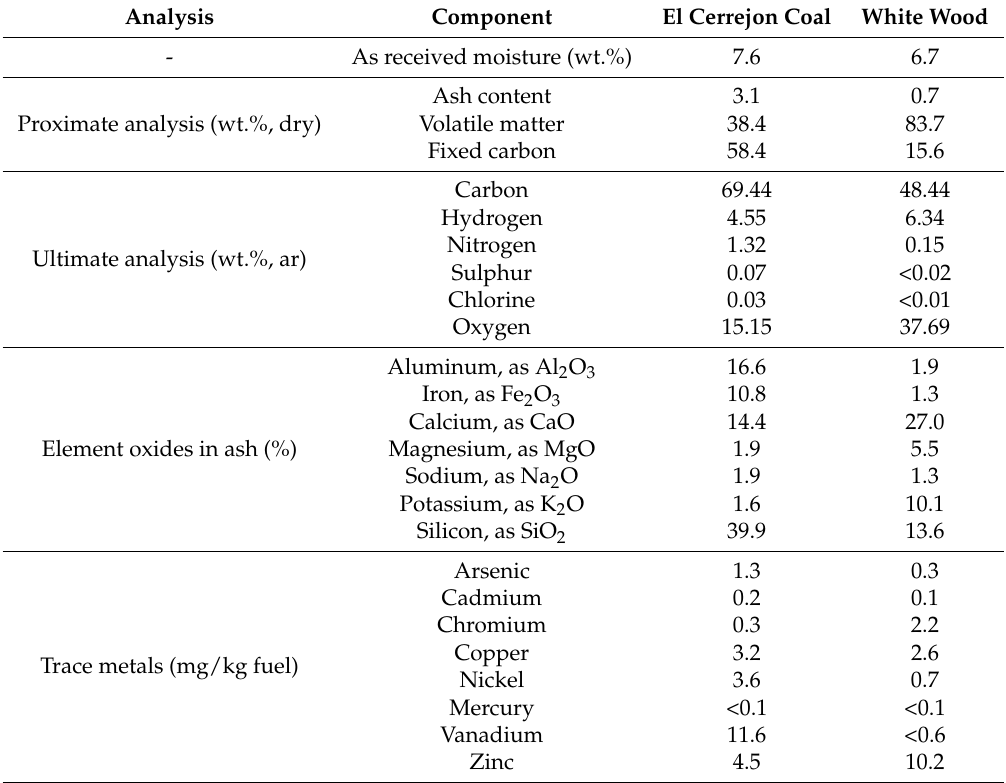
Table 1. Proximate, ultimate, and elemental analyses of the coal and biomass fuels, assessed via standard